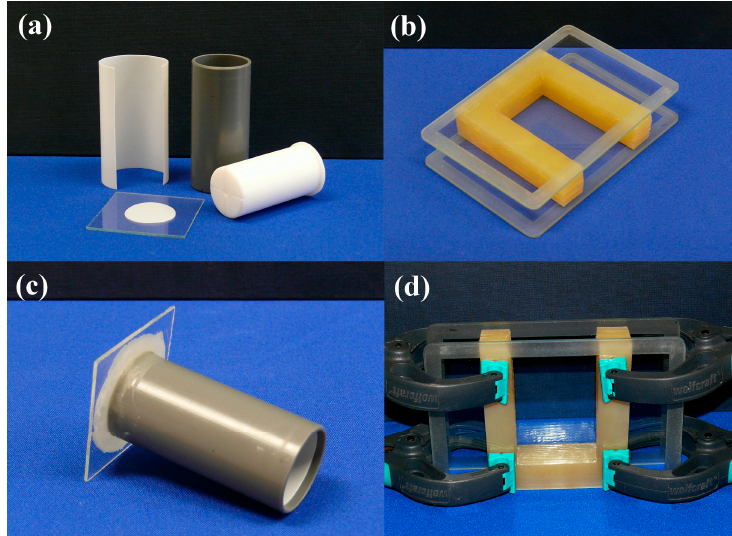
Figure 1. Photographs of disassembled and assembled cylindrical and rectangular molds used for gel casting. ( a ) Parts of cylindrical molds are: machined PVC tubing, PTFE liners, glass base plate, PTFE plunger for extruding alcogel; ( b ) Rectangular mold consisting of a U-shaped mask made of silicone rubber, two glass plates, plus PTFE liners (not shown, for the sake of visibility); ( c ) Assembled cylindrical mold; base plate and tube are glued together with paraffin; ( d ) Assembled rectangular mold with spring clamps (PTFE liner is not shown).